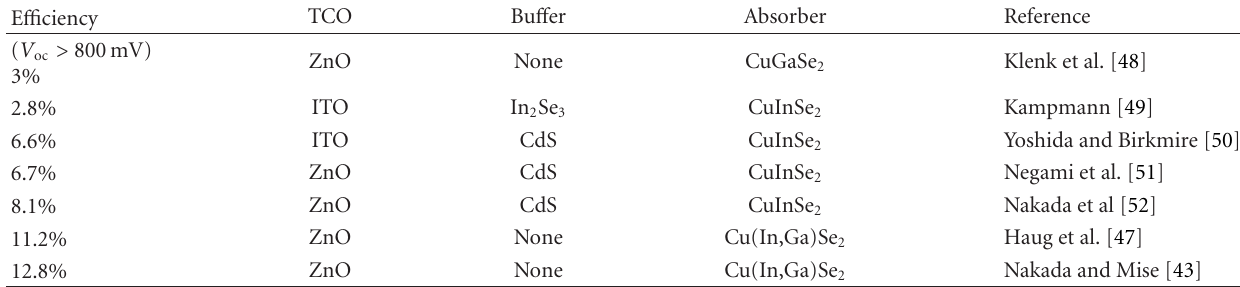
Table 1: Superstrate